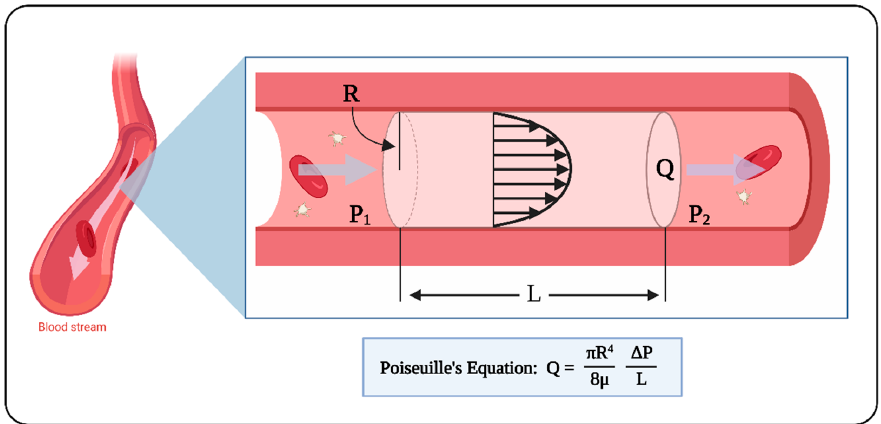
Figure 4. Laminar flow of an incompressible fluid inside an axisymmetric vessel. Under steady state conditions, the volumetric flow rate, Q, is described by the Poiseuille equation (Equation (1)). The velocity profile is parabolic, and the fluid flows from higher to lower pressure. Poiseuille flow can be used to approximate blood flow. ∆ P = P 1 − P 2 ; L: length; R: radius; µ : fluid viscosity. Created with BioRender.com (accessed on 24 July